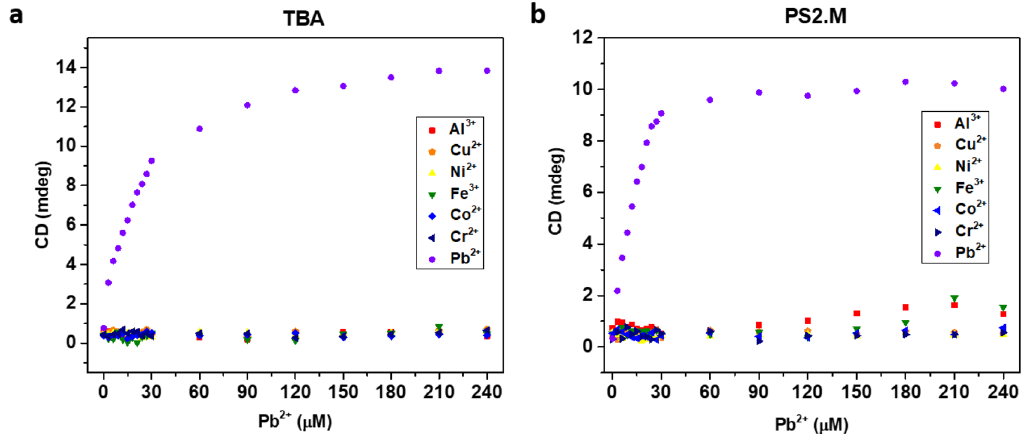
Figure 7. Cross-reactivity of TBA and PS2.M to other metal ions at 314 nm. ( a ) Cross-reactivity of metal ions to TBA. ( b ) Cross-reactivity of metal ions to PS2.M.